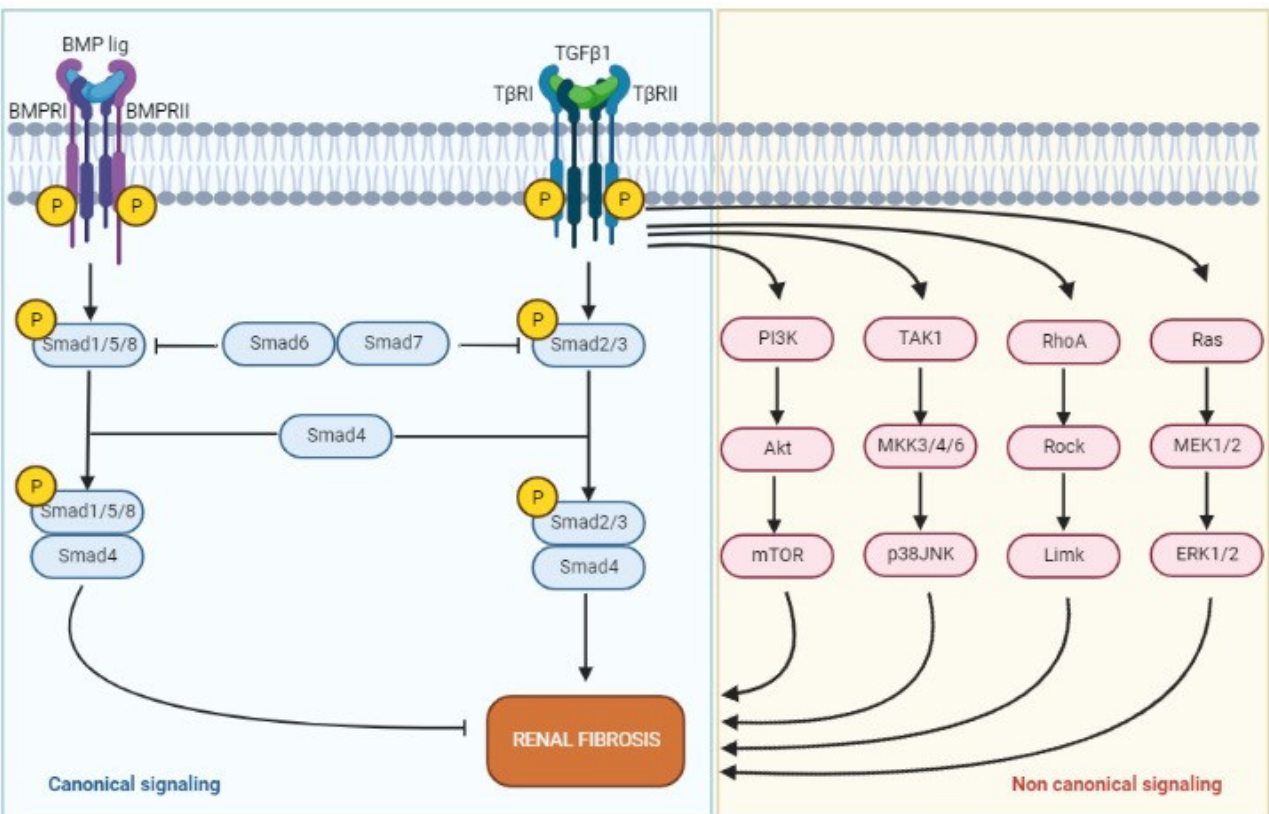
Figure 1. Representation of the TGF- β /Smad signaling. TGF- β 1 binds to its receptors and induces a cascade of signal transductions via both canonical (blue) and noncanonical (red) signaling. When TGF- β 1 binds to its receptors, it triggers the phosphorylation and activation of Smad2/3, which translocate to the nucleus, inducing the transcription of TGF- β 1-responsive genes and a pro-fibrotic response. This process can be blocked by Smad7, who inhibits Smad2/3. On the other hand, when BMP7 binds to its receptors triggers the phosphorylation on Smad1/5/8, which induce an anti-fibrotic response. In addition, TGF- β also activates the noncanonical signaling pathways able to influence renal inflammation and fibrosis. In this case, renal fibrosis is caused by the activation of pathways such as MAP kinase, PI3K/Akt, and Rho kinase, and is triggered by mediators such as angiotensin II and advanced glycation end products (AGEs). [Created with Biorender (https://biorender.com), accessed on 7 November 2022].